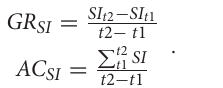
Static Index (SI)